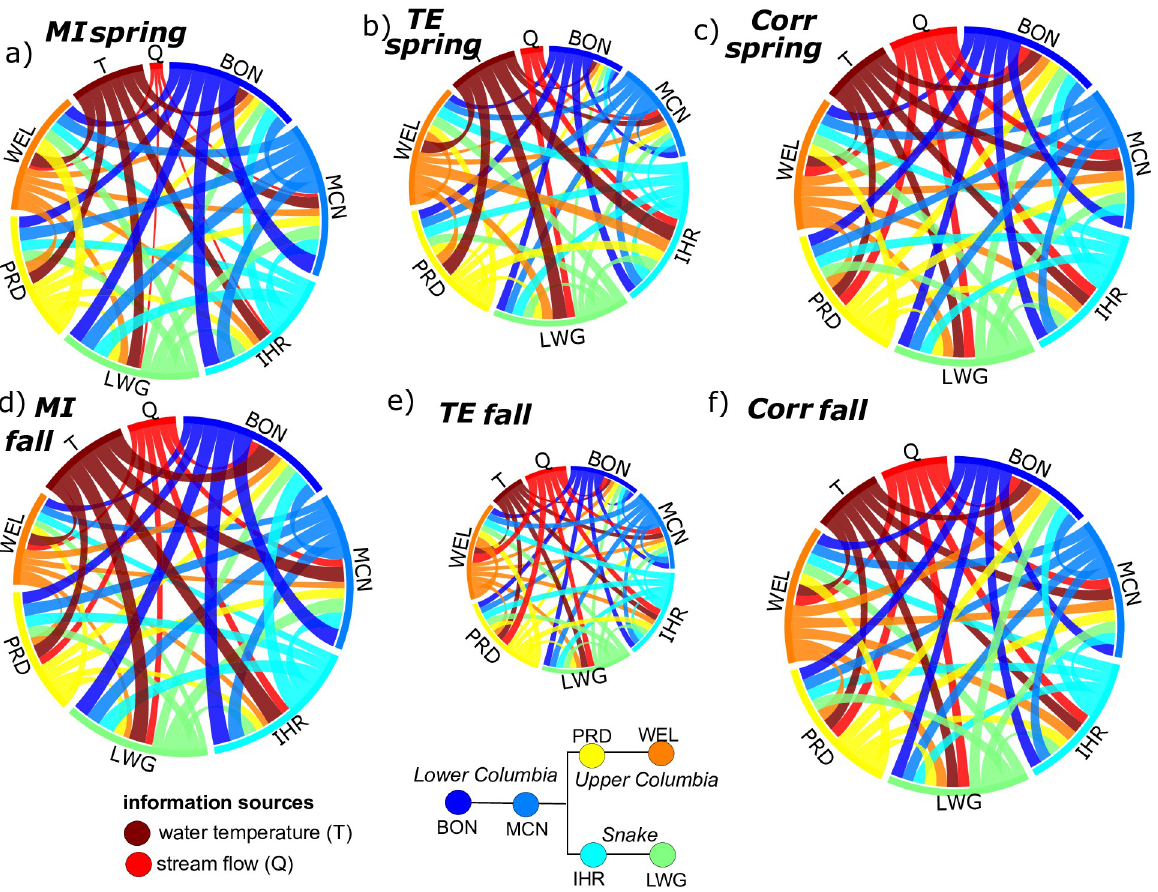
Fig 7. Mutual information MI (a,d) , Transfer Entropy TE (b,e) , and linear correlation Corr (c,f) links between salmon counts at dams, flow rate ( Q ), and water temperature ( T ) for spring run (a-c) and fall run salmon (d-f) . Q and T correspond to Lower Columbia data only, as strengths are similar for other Q and T variables. Link widths for MI and TE indicate relative information strengths, and colors correspond to information